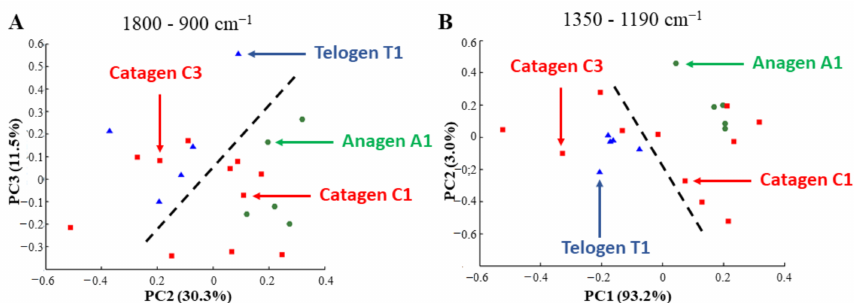
Figure 6. Discrimination of hair follicles at different phases of hair growth cycle by PCA. ( A , B ) PCA score plot performed on normalized mean spectra of the ORS region 4 in the 1800–900 cm − 1 ( A ) or 1350–1190 cm − 1 ( B ) range and carried out on anagen A1, catagen C1/C3, and telogen T1 hair